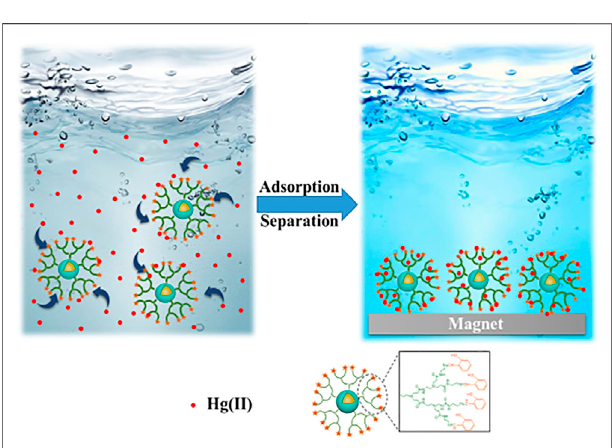
FIGURE 5 | Adsorption mechanism of the Fe 3 O 4 @SiO 2 -G2.0-S.